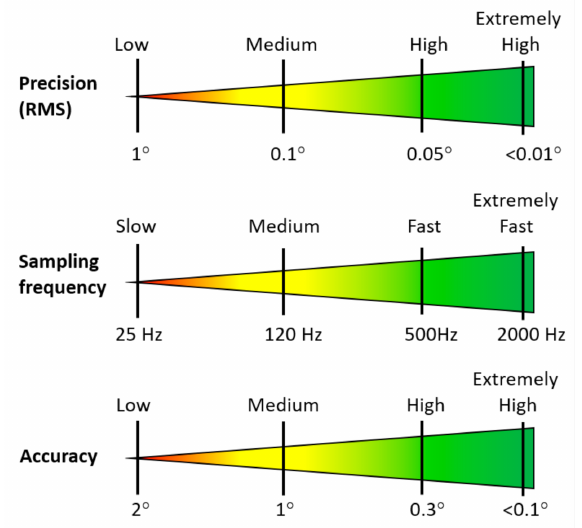
Figure 8. Performance specifications of current eye tracking